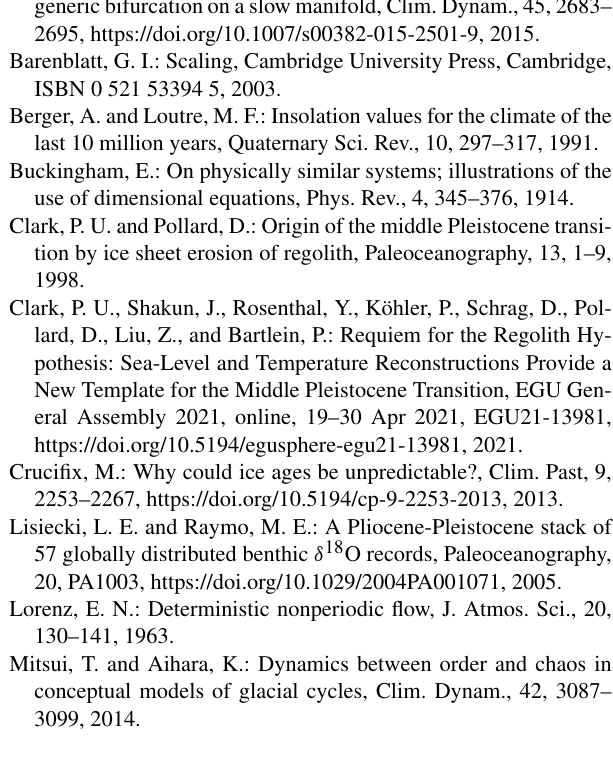
Fig. 1 are available at https://doi.org/10.5281/zenodo.6525434 (Ver- bitsky,